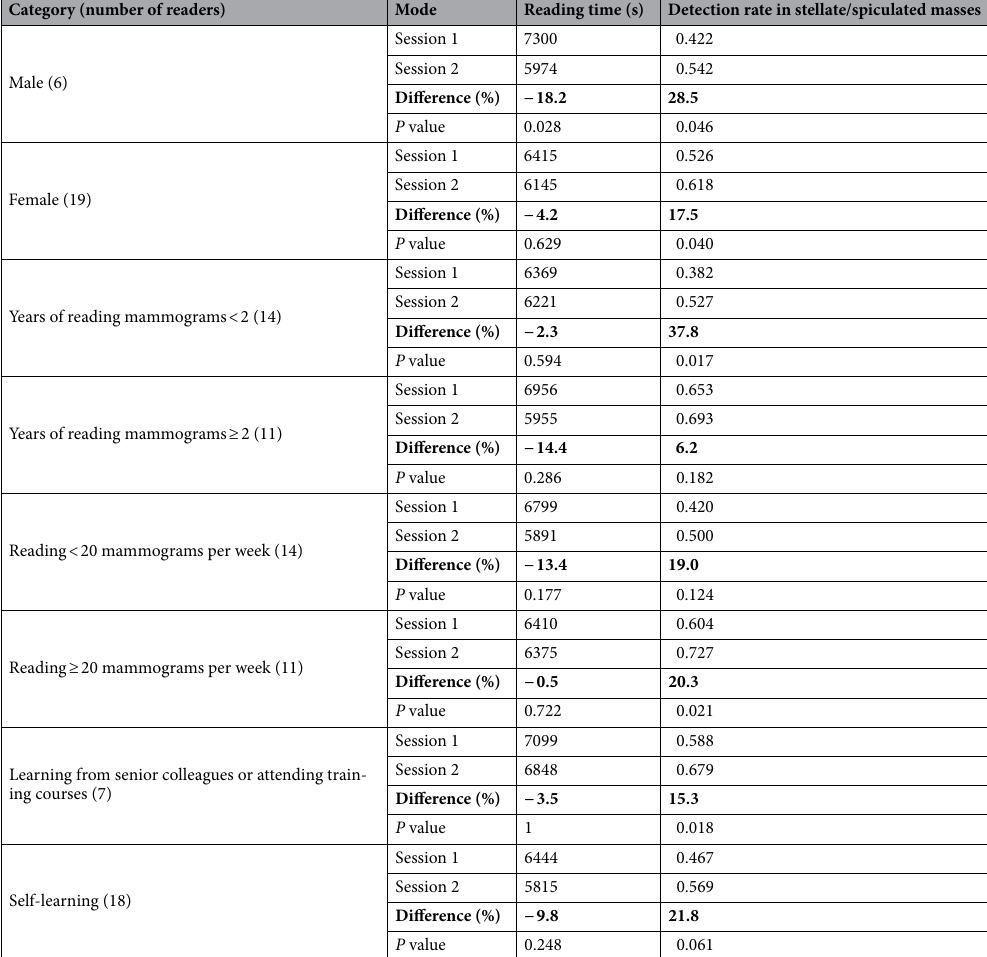
Table 1. Comparisons of the performances of readers in different characteristics in two reading sessions (Session 1: Training set, Session 2: Original test